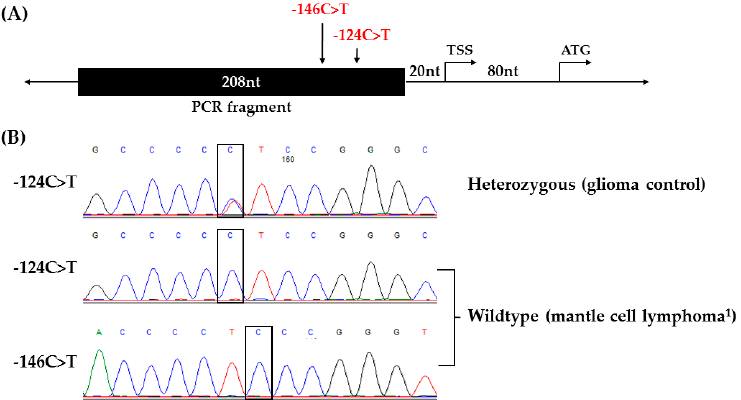
Figure 1. Screening of TERT promoter mutations in Non ‐ Hodgkin lymphomas (NHLs). ( A ) Schematic of the amplified region and the location of − 124C>T and − 146C>T in the TERT promoter. ( B ) Sequencing chromatographs of the TERT promoter locus in a glioma control that is heterozygous for − 124C>T (top) and a representative NHL tumor sample that is wildtype at both positions (middle and bottom). 1 A representative trace for wildtype at both